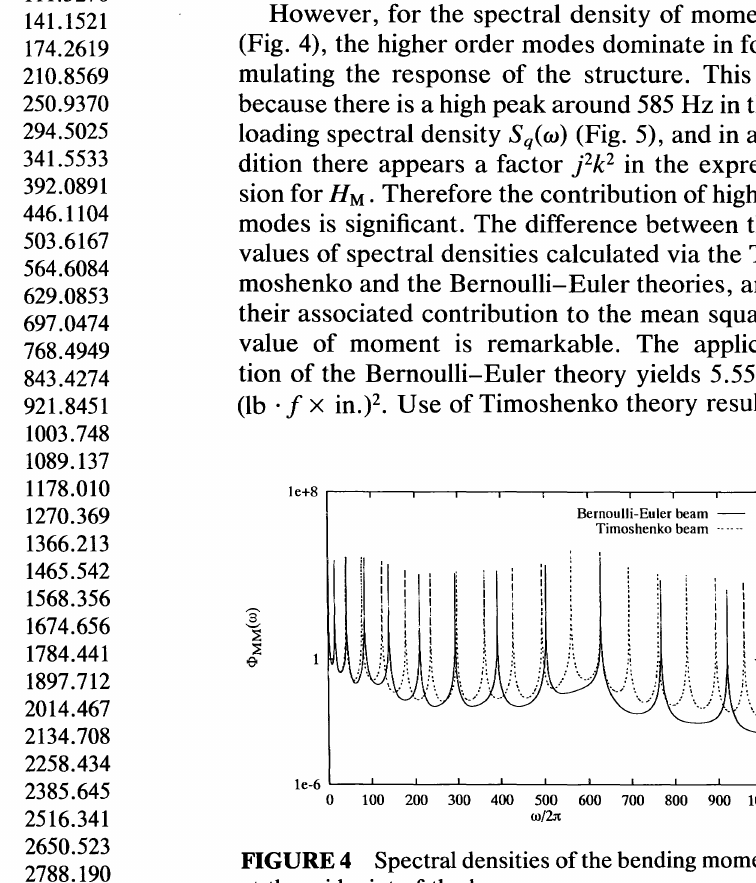
dant difference constituting about 1.2%.